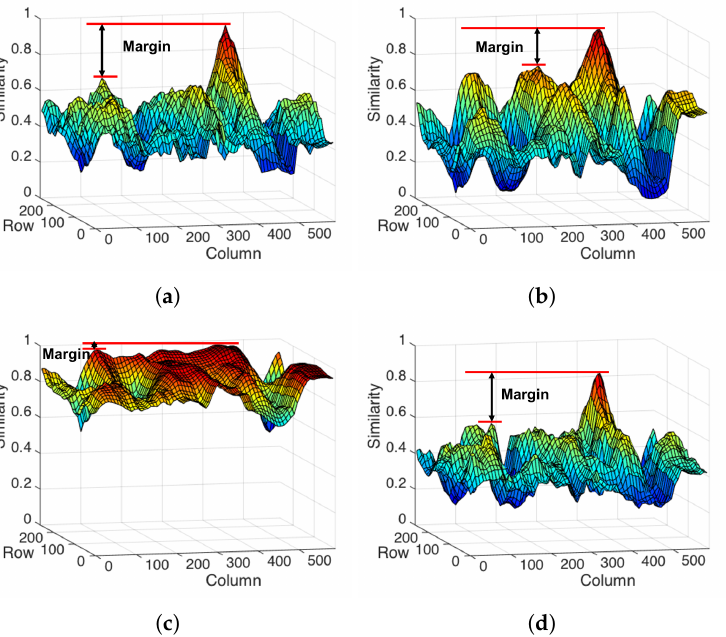
Figure 11. Analysis of profile plots which are used CI, CCH, ABC, and ABC-ML methods in Figure 10b. ( a ) The profile of similarity in ABC. ( b ) The profile of similarity in CI. ( c ) The profile of similarity in CCH. ( d ) The profile of similarity in